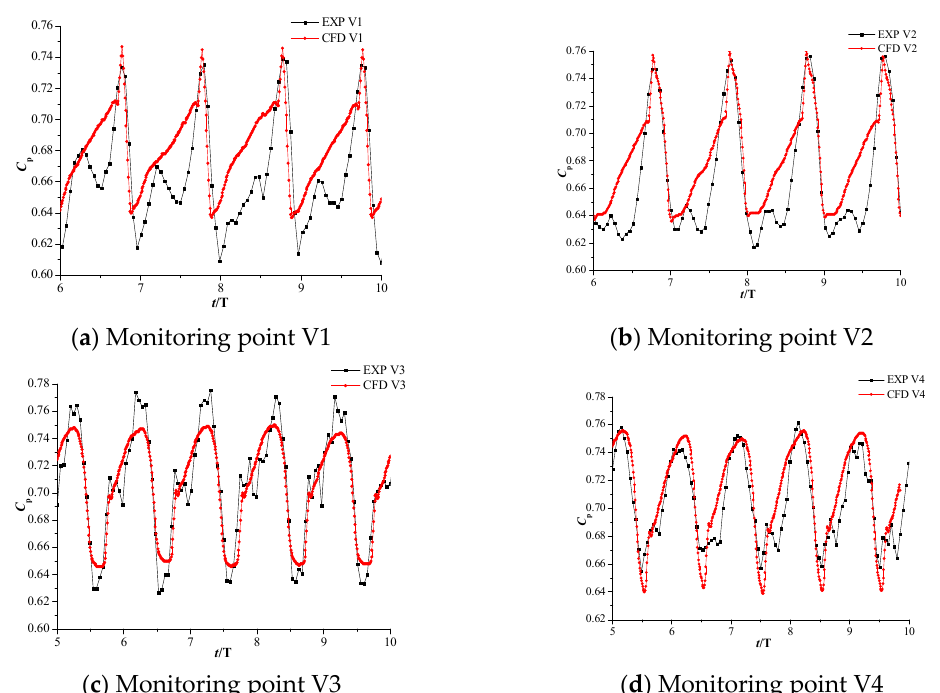
Figure 6. Comparison of pressure distribution in model 1 at design flowrate.